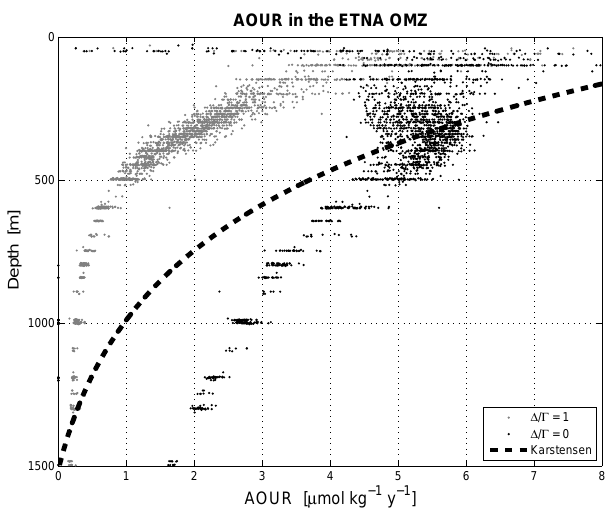
Figure 16. AOUR in the ETNA OMZ (between 4 and 14 ◦ N and east of 32 ◦ W). The AOUR was calculated using the TTD approach with two different assumptions about mixing: black dots corre- sponds to no mixing, (cid:49)/(cid:48) = 0; grey dots to moderate mixing, (cid:49)/(cid:48) = 1. The dashed line marks AOUR as obtained by Karstensen et al. (2008) using CFC-11 ages from the ventilated